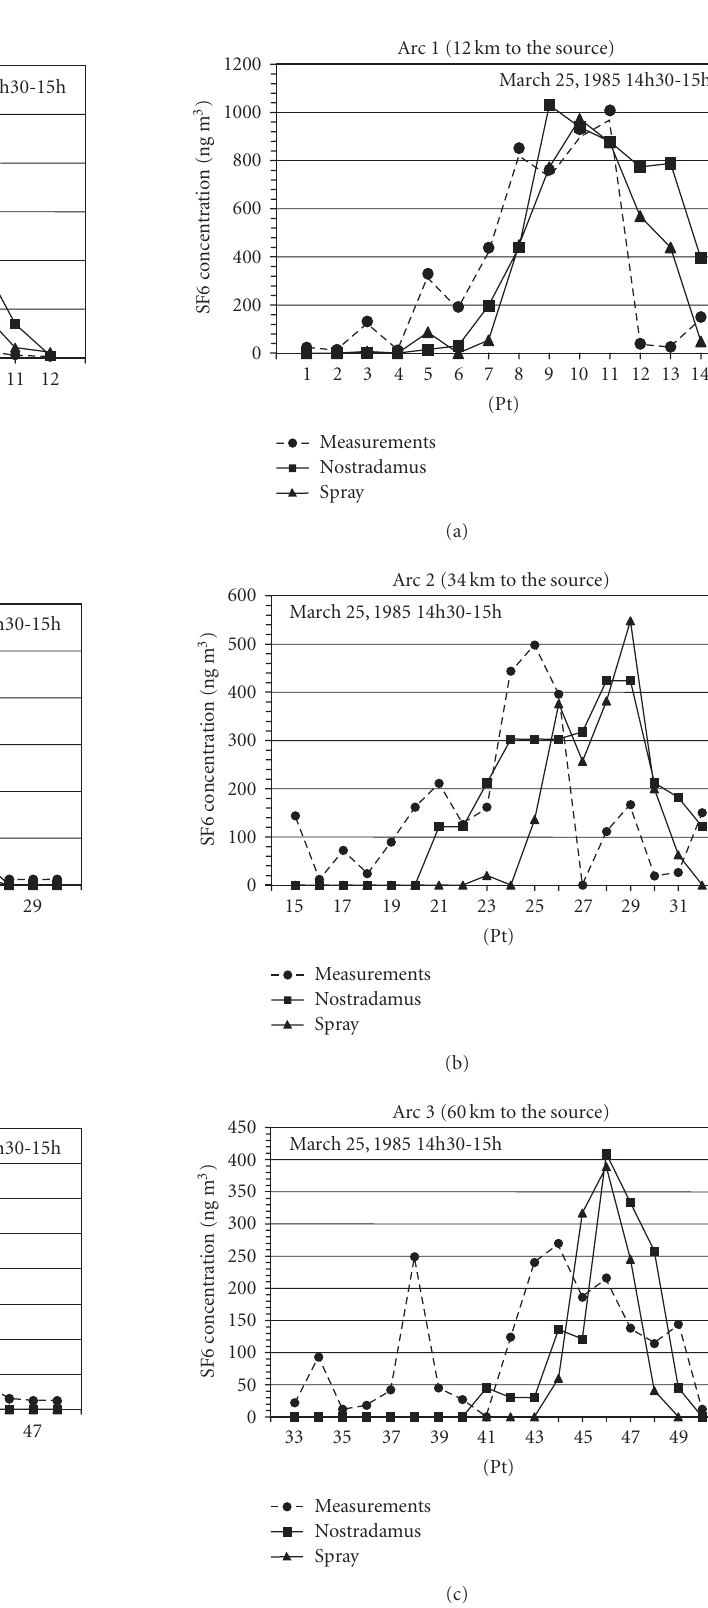
Figure 6: Comparison of SF6 concentration during experiment 4 on three arcs of monitoring points between measurements (at 1 meter above ground level) and NOSTRADAMUS and SPRAY cal- culations (at 10 meters above ground